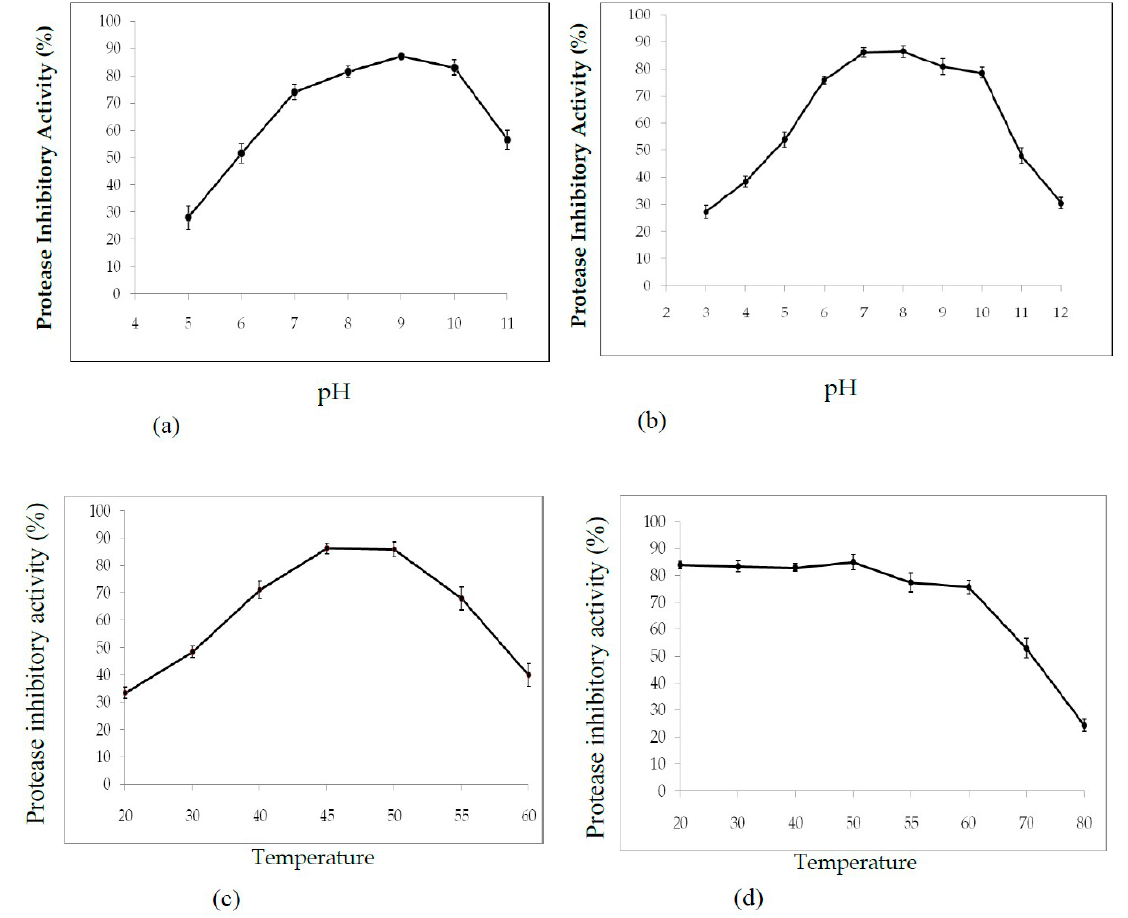
Figure 3. E ff ect of pH and temperature on PDInhibitor activity: E ff ect of pH on PDInhibitor activity ( a ) and stability ( b ). Inhibitor activity was assayed against trypsin at various pH values. For stability studies, the protease inhibitor was incubated in medium with di ff erent pH values for 12 h and assayed for residual inhibitor activity under standard conditions. E ff ect of temperature on PDInhibitor activity ( c ) and stability ( d ). Inhibitor activity was assayed against trypsin at various temperatures. For stability studies, the protease inhibitor was incubated at di ff erent temperatures, drawn at various time intervals and assayed for residual inhibitor activity under optimal pH and temperature conditions. The data shown are the mean ± SD ( n =